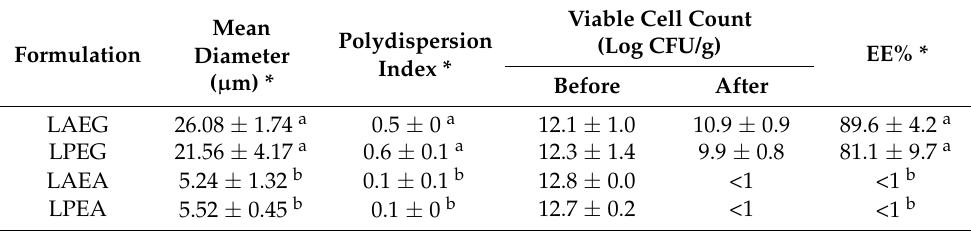
Table 1. Mean diameter, polydispersity index, viable cell count before and after encapsulation, and the probiotic encapsulation efficiency